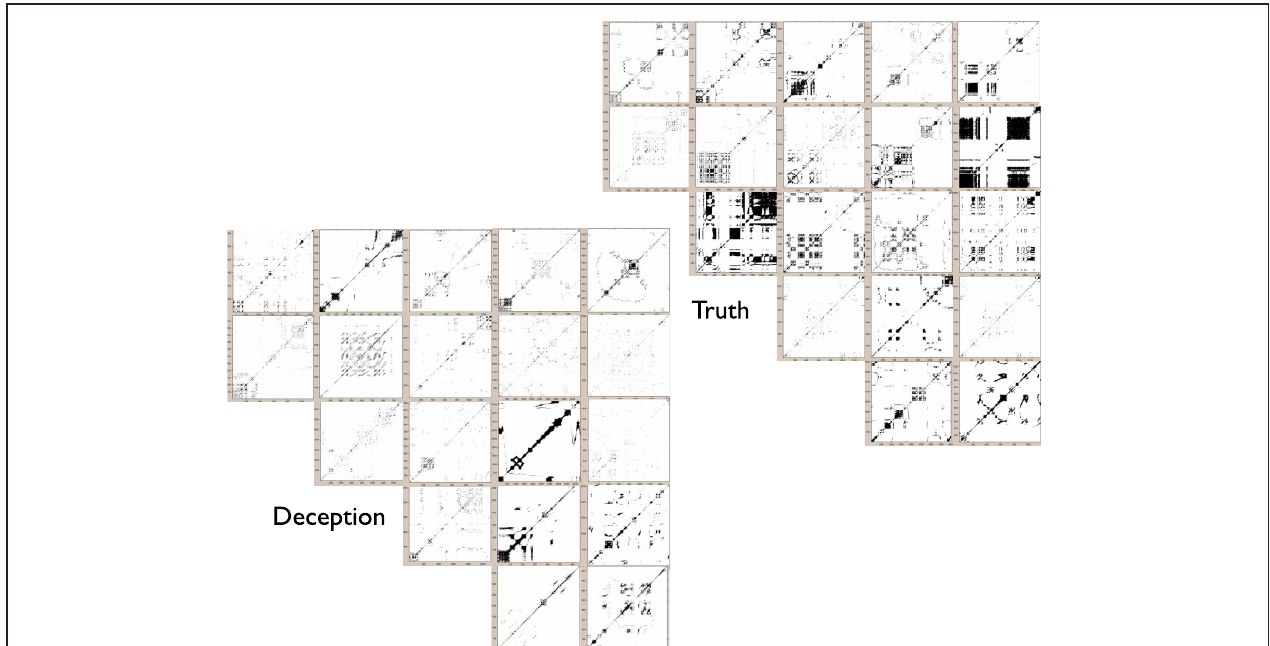
FIGURE 7 | For upper face movements, mosaic of recurrence plots for randomly selected subset of deceptive and truthful responses for critical questions. Deception is shown in the lower panel and truth in the upper panel. For truth, there is overall higher determinism than deception, as indicated by the greater percentage of recurrent diagonal lines. Each plot shown in this array is a reflection of the “recurrences”